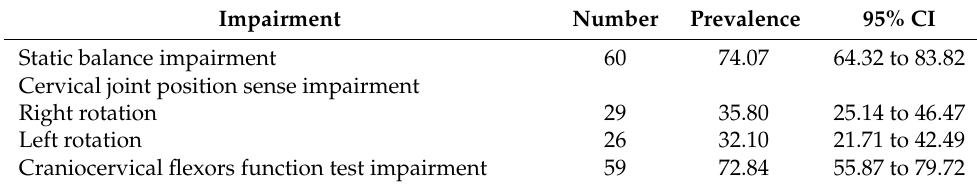
Table 2. Prevalence of impairment: balance, cervical joint position sense, and muscle function.